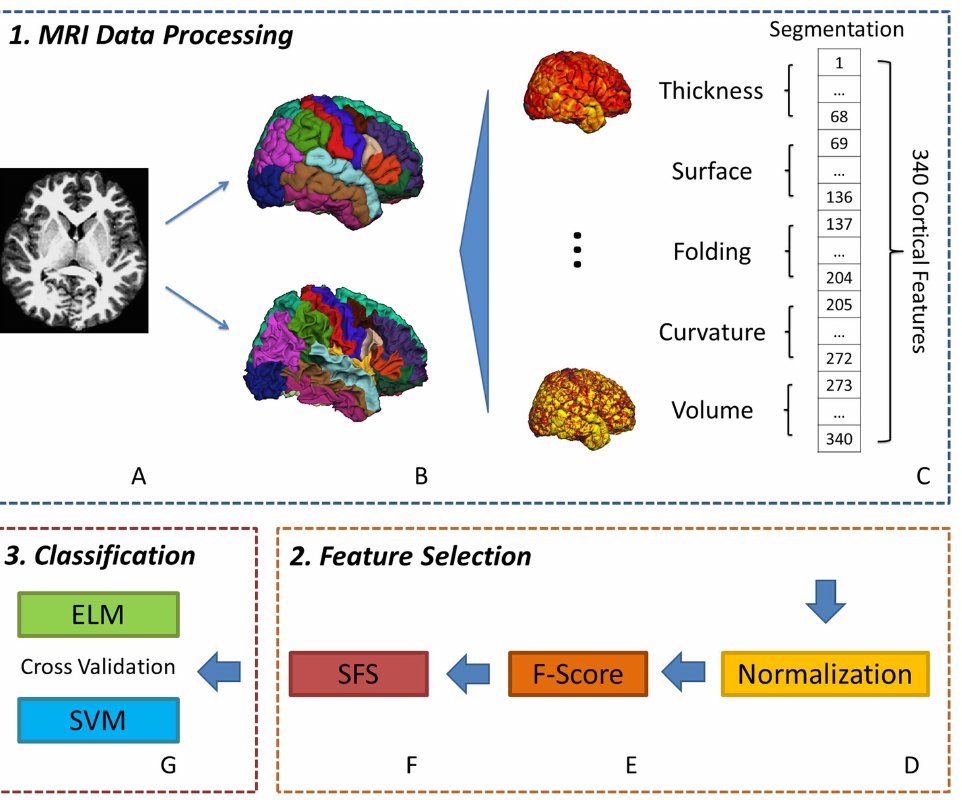
Figure 1. A flowchart for ADHD classification using human cortical feature measurements from MRI. (A) A T1-weighted anatomical image preprocessed with nonuniformity correction and registration. (B) The upper and lower images refer to the pial vertices (outer gray surface) and white vertices (inner gray surface), respectively, that were extracted and reconstructed in stereotaxic space from (A). (C) Five basic cortical features, including thickness, surface area, folding index, curvature and volume, were measured from the divisional cortical surfaces, comprising a total of 340 brain features for each subject. (D) All the brain features were normalized to the range from 0 to 1. (E) The normalized data were rearranged in accordance with the F-score in descending order. (F) The SFS method was used to further select the features that enhance the classification accuracy. (G) The classification accuracy of both ELM and SVM learning algorithms was tested using the leave-one-out cross-validation method.